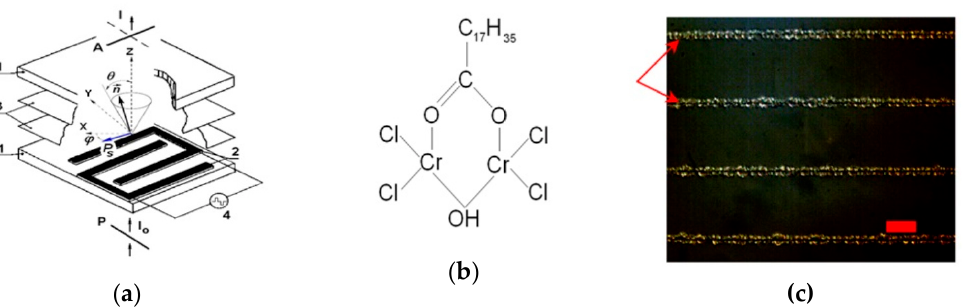
Figure 14. Schematic representation of geometry of a vertically aligned DHF cell [40]: ( a ) 1—glass plates, 2—in-plane electrodes, 3—smectic layers parallel to glass substrates, 4—a voltage generator. ( b ) The chemical structure of stearic acid chromium salt. ( c ) The texture of Vertically aligned DHFs (VADHF) cell placed between crossed polarizers at V = 0 V. The red mark is 20 μ m.